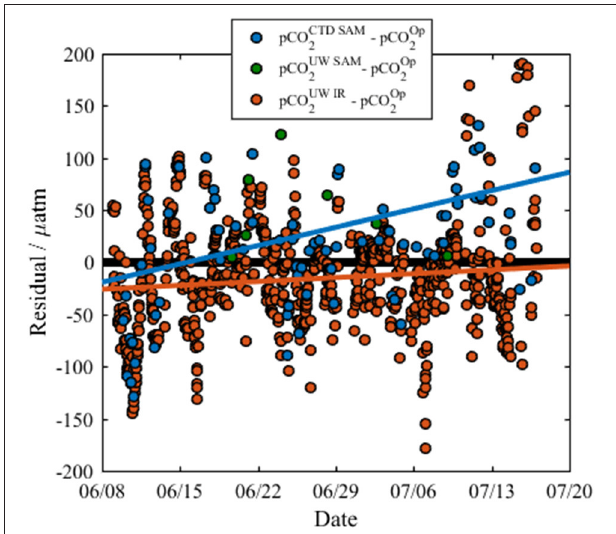
FIGURE 7 | The residuals between the optode sensor data and other pCO 2 data, where residual refers to the difference between the reference sample data and the optode as listed in the legend. pCO 2op , optode measured pCO 2 ; pCO 2UWIR , Infrared PML pCO 2 analyzer; pCO 2UWSAM , pCO 2 - calcTA calculated from discrete underway DIC and TA samples; and pCO 2CTDSurf , pCO 2 - calcTA calculated from discrete surface water DIC and TA samples collected from the CTD rosette. The residuals from the infrared PML pCO 2 analyzer show a slight positive trend (orange line, residual = 0.53 × date − 390,000, R 2 = 0.01, n = 698, p = 0.005) over the course of the cruise. The residuals from CTD surface samples show a stronger positive trend (blue line, residual = 2.5 × date − 1,800,000, R 2 = 0.16, n = 71, p = < 0.001). The residuals from the underway samples show no significant trend due to the small sample size ( n = 7). The solid black line indicates where there is zero difference between the data collected by the optode and data from a reference method.